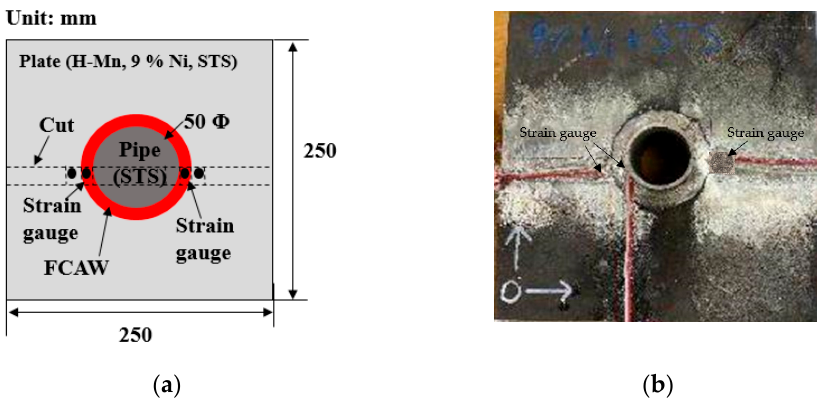
Figure 4. Location of strain-gauge attachment: ( a ) schematic and ( b ) specimen photograph. Table 6. Specifications of the strain gauges.